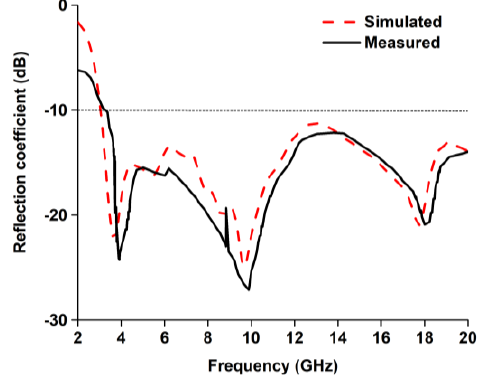
Figure 8. Simulated and measured reflection coefficient of the UWB antenna.